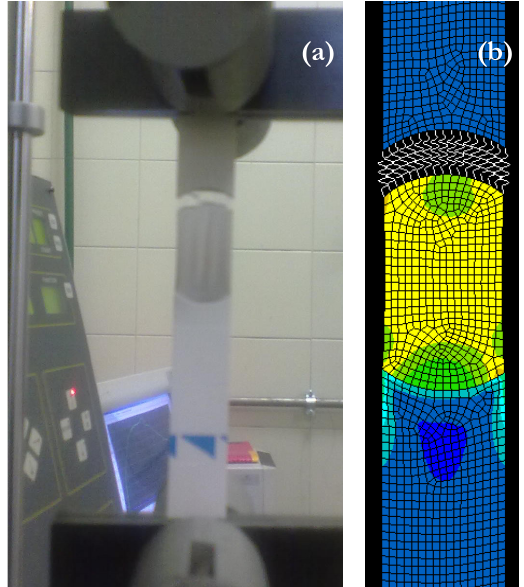
Figure 1: Failure of a heterogeneous specimen under tensile test (a) and the finite element simulation of the experiment